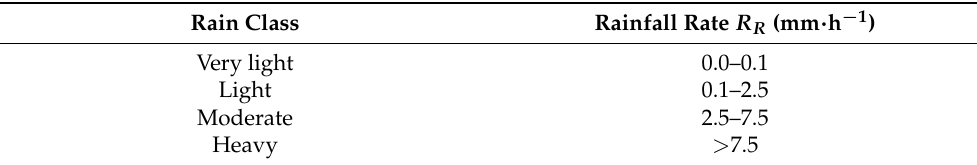
Table 1. Different rain classes according to French standard NF P 99-320 [21].